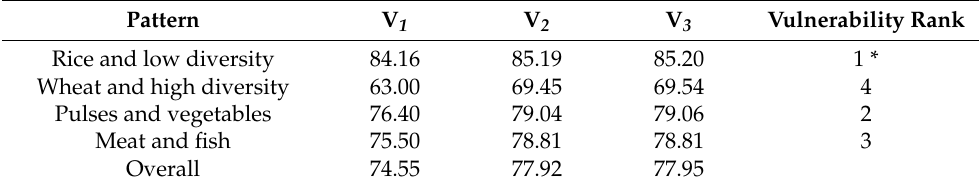
Table 4. Vulnerability scores of household dietary